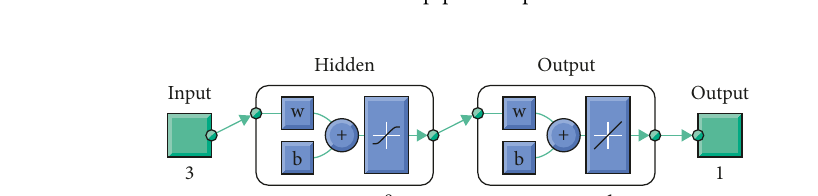
Figure 3: Ramp plot of